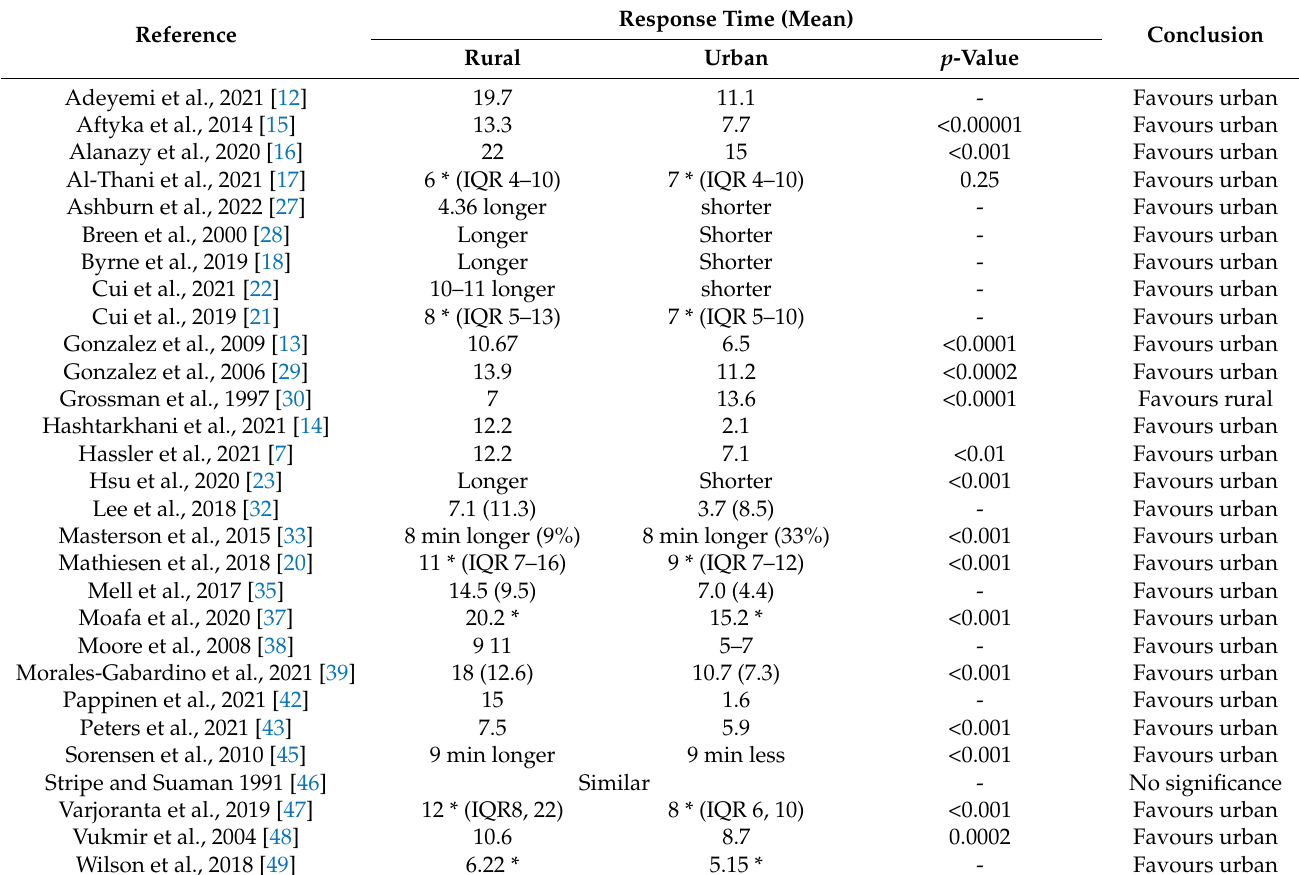
Table 2. Differences between rural and urban areas regarding response time.